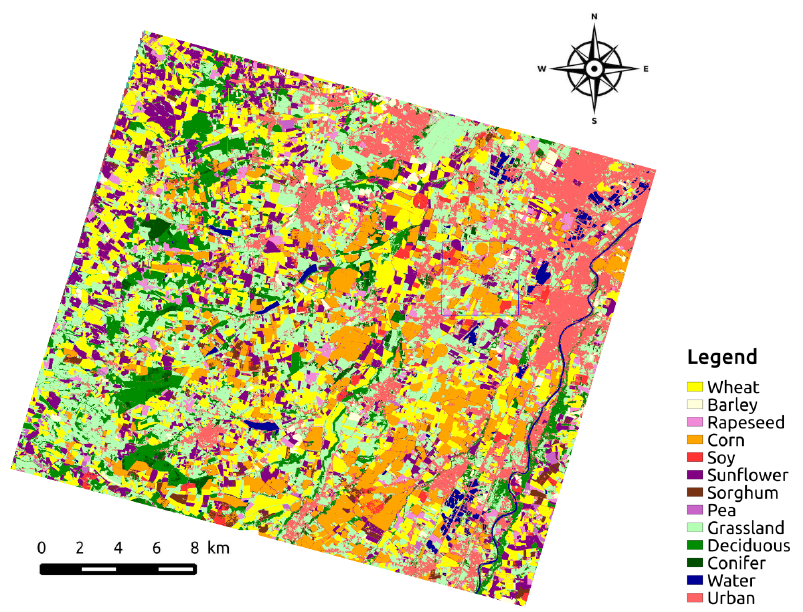
Figure 1. An example land cover